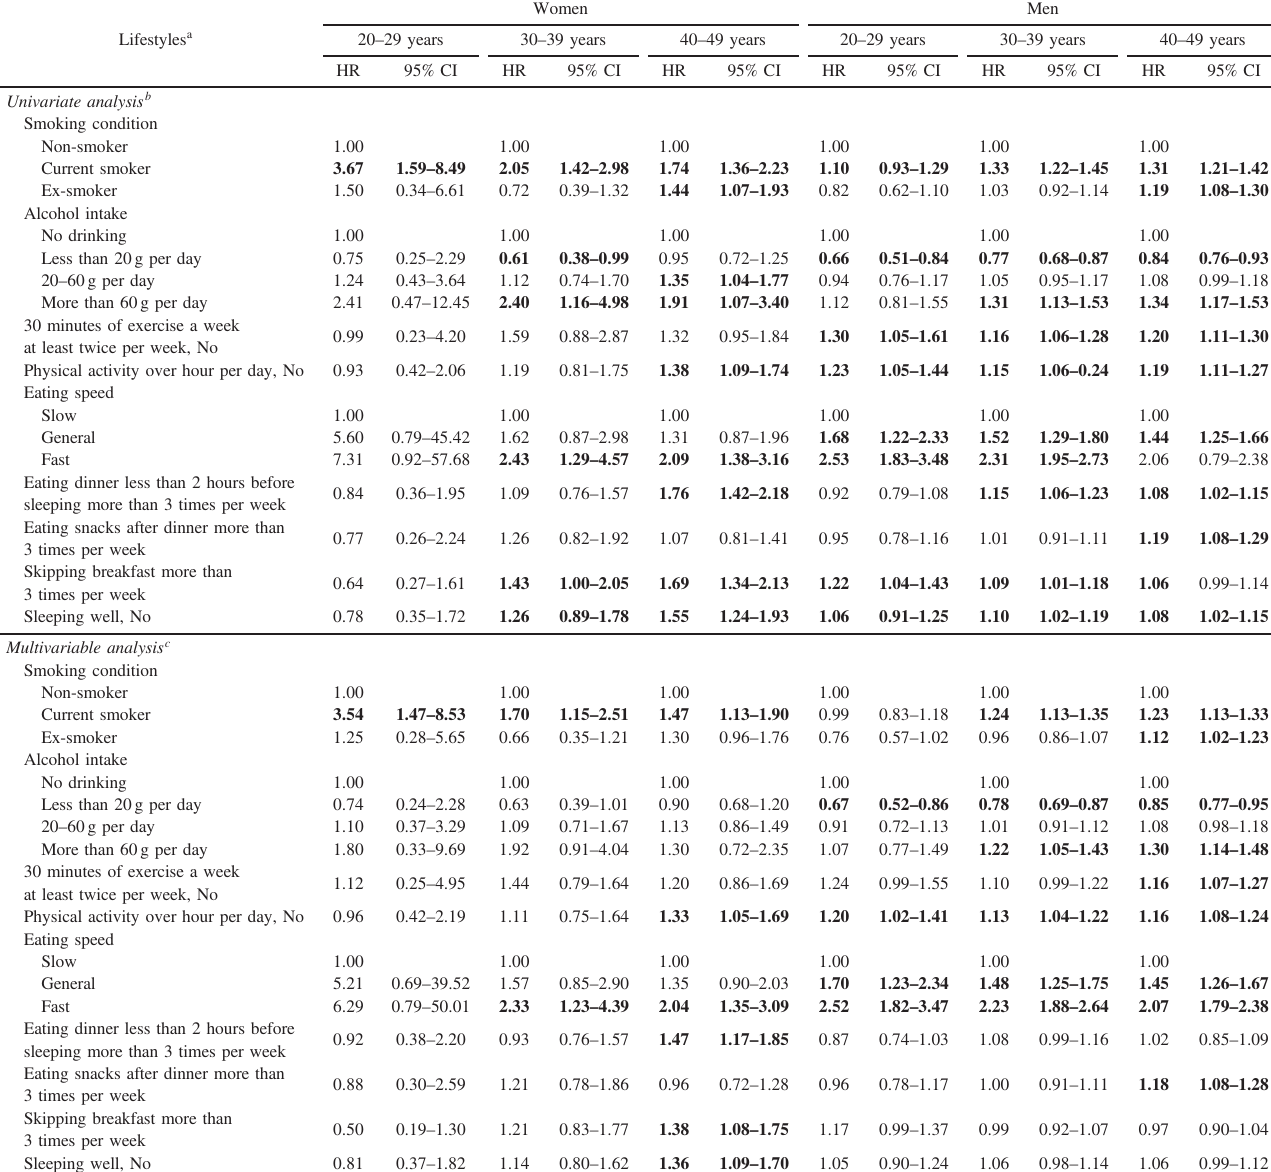
Table 5. Associations between MS and risk factors among age groups during 6-year follow-up Lifestyles